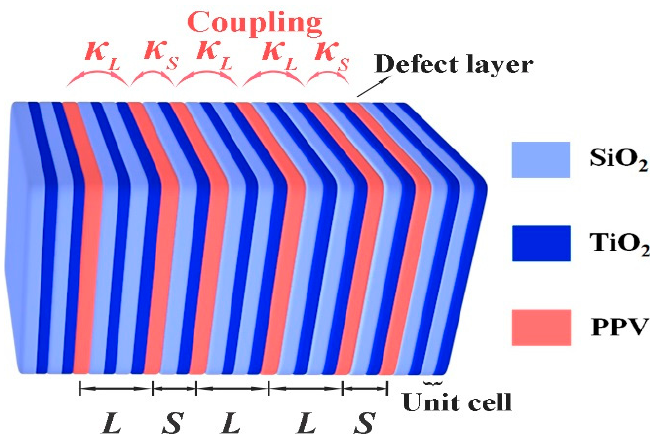
Figure 1. Scheme of 1D Fibonacci-spaced defect resonators. The PPV layers are inserted in the period stacks of SiO 2 /TiO 2 structures, in which the PPV acts as both the defect cavity and the gain medium. of defect cavity make it extremely suitable for creating the coupled microcavity